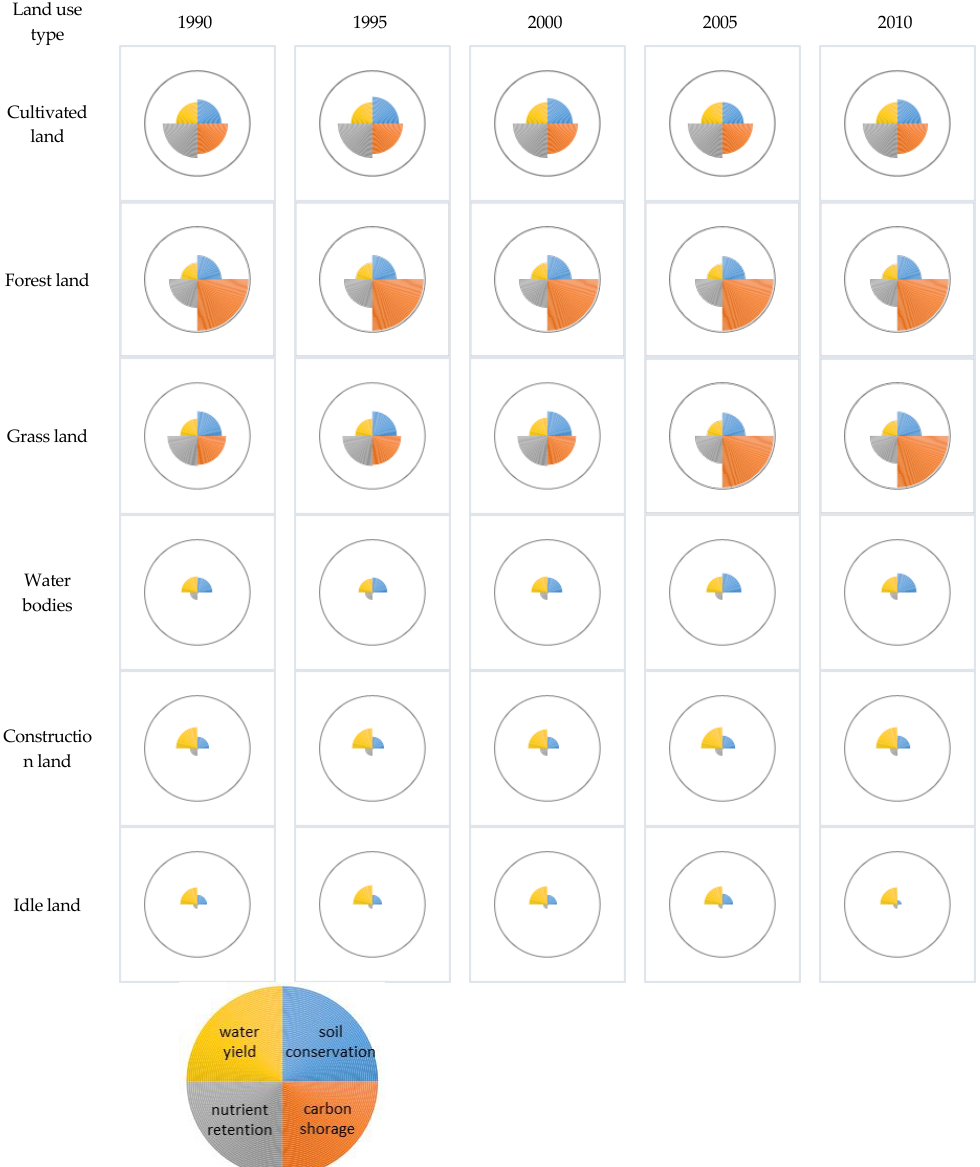
Figure 8. Variation in ecosystem services between different ecosystems. Notes: the normalization formula is S ij = A ij /T i , where S ij is the normalized value of the i -th ecosystem service for j -th land use type, A ij is the average of the i -th ecosystem service for j -th land use type, and T i is the average of i -th ecosystem service in the mountainous karst area.